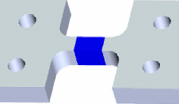
Polymers 2021 , 13 , x FOR PEER REVIEW Figure 12. Area of the specimen characterized with X-ray microtomography (blue).